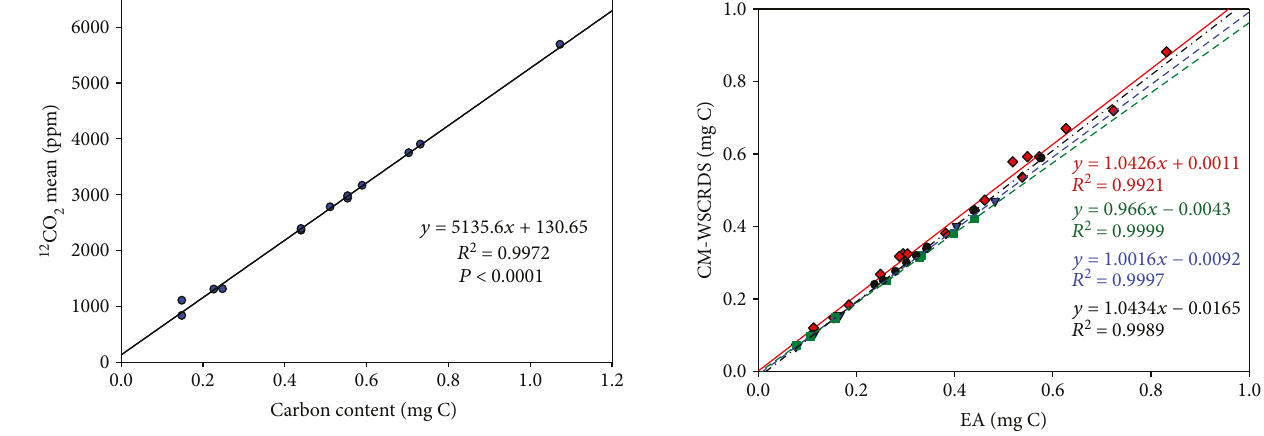
Figure 2: Standard curve for 12 CO concentration (ppm) versus 2 C content (mg C). Figure 3: Correlation between contents determined by CM-CRDS and comparison system for standard materials and reference soil. Table 2: Measured C content and recovery rates (RRs) of three standard materials and three soils determined by CM-CRDS and comparison system